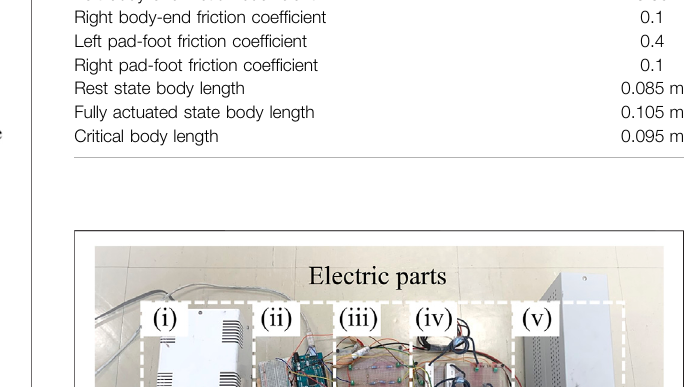
Frontiers in Robotics and AI |